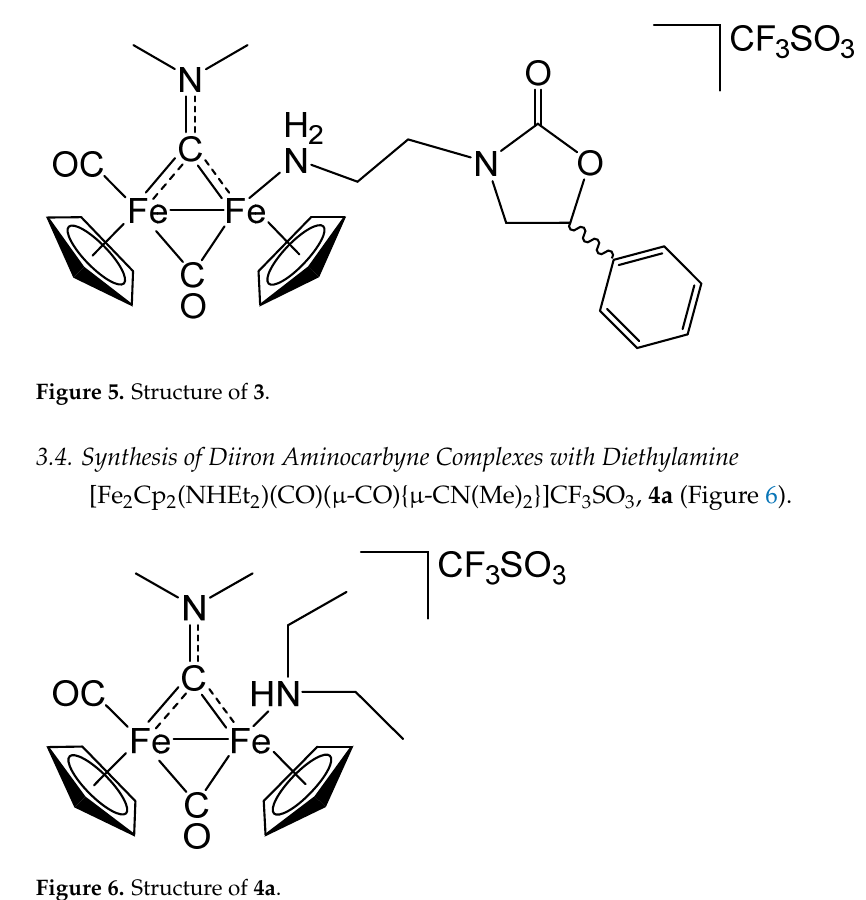
Figure 1. Structure of 2a (left: cis isomer; right: trans